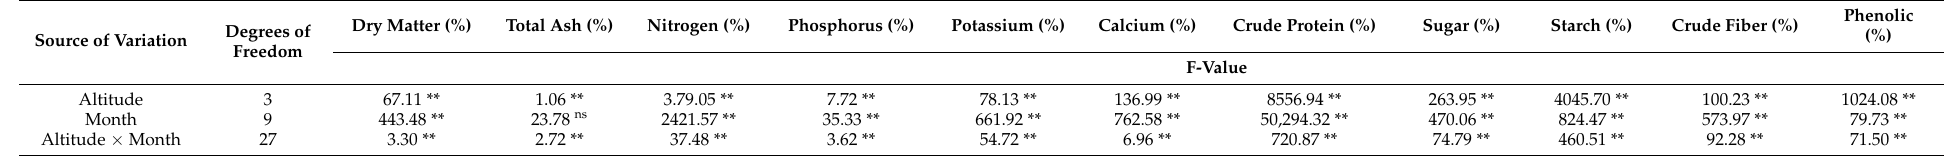
Table 3. Two-way analysis of variance for altitude and month of foliage